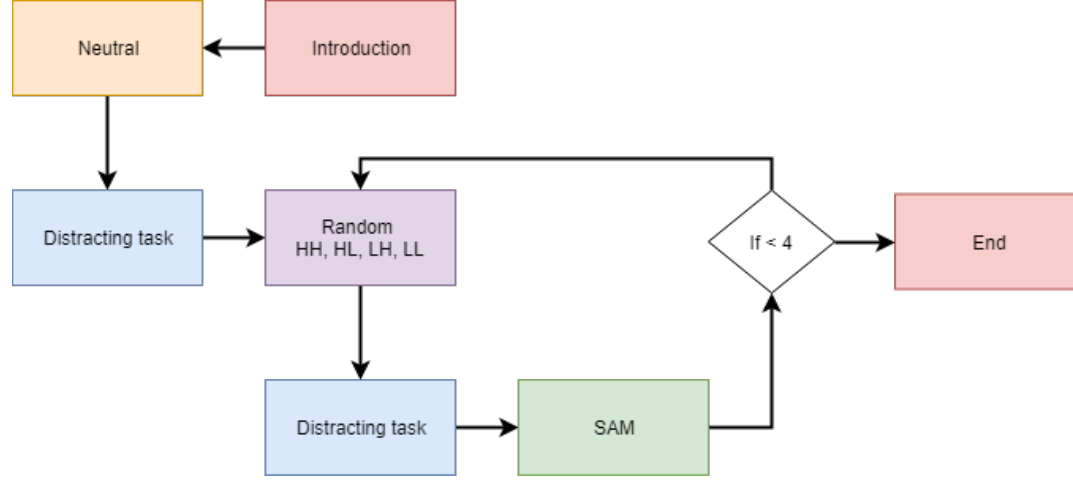
Figure 5. Flowchart of the experimental design used in E-Prime. Self-assessment manikin (SAM). Simultaneously, the EmoSys Software Suite captures and stores both EEG signals (raw signals) and emotional states obtained from the Emotiv EPOC+ API. In this study, only the emotional